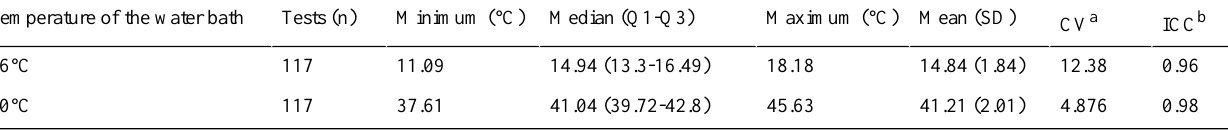
Table 1. Distributions of the temperatures of the 39 HEARThermo devices in the water